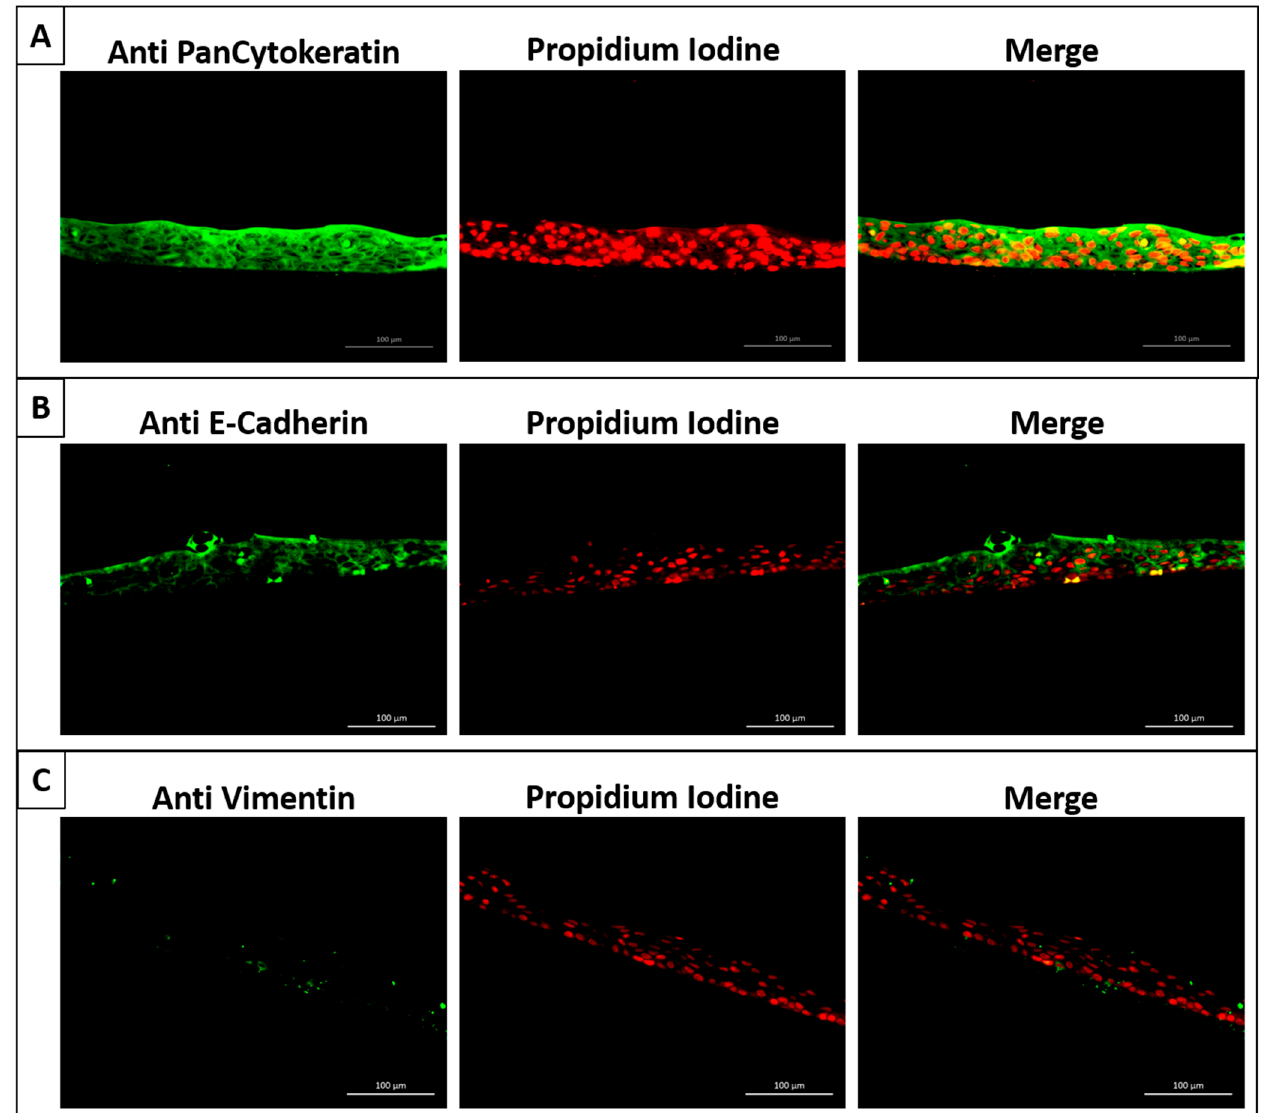
Figure 3. Pretransplantation evaluations of nasal epithelial cell sheets. ( A ): Live–dead staining results showed a high rate of alive cells (green color) in the harvested sheet with a few dead cells (red color). ( B ): The cell sheets consisted of multi- layered mucosal epithelial cells with a round-shape appearance under HE staining.